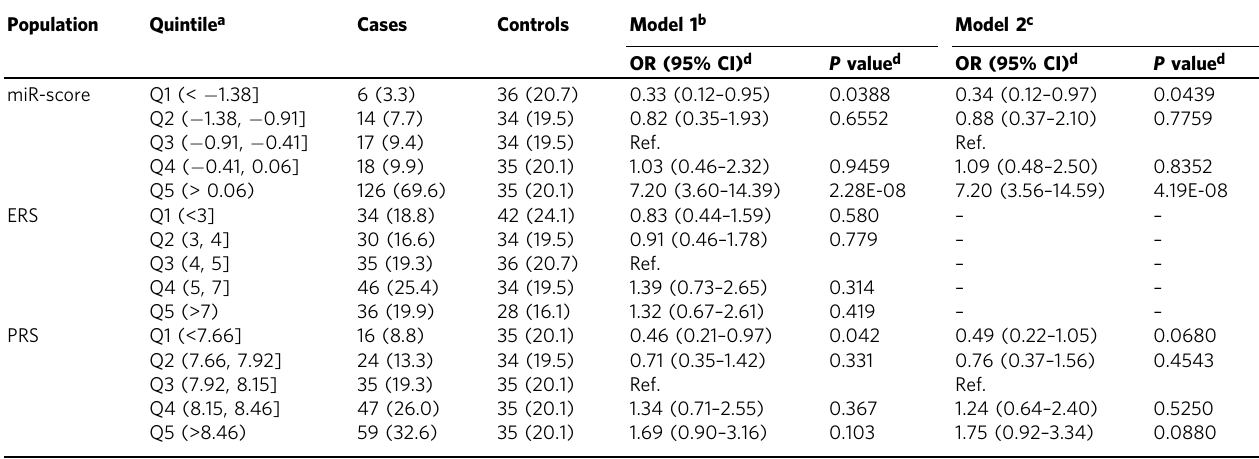
Table 2 Individual associations of miR-score, ERS and PRS with CRC incidence in prospective set participants with all scores available ( N cases/controls = 181/174).